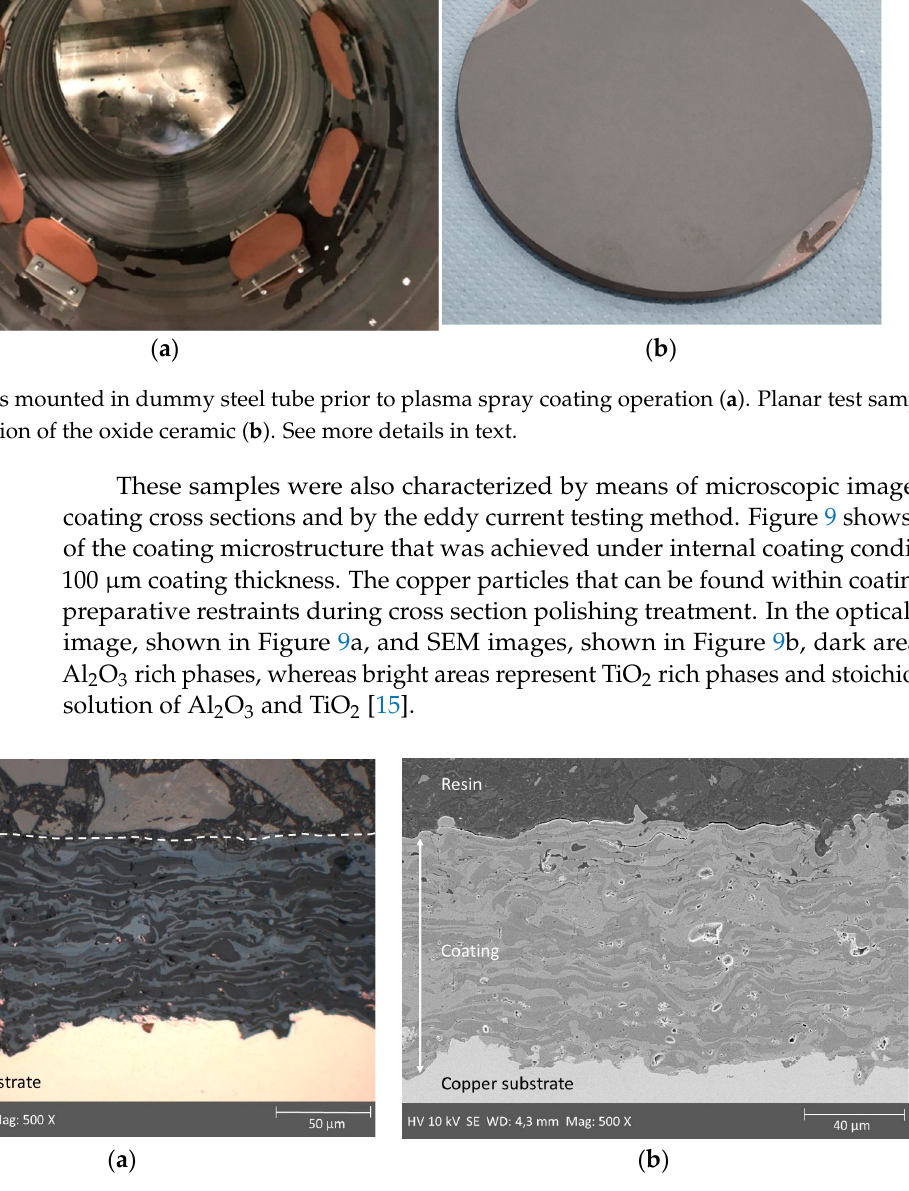
Figure 9. Microscopic images of coating cross-sections in optical microscope ( a ) and SEM ( b ). Some copper particles can be found within the ceramic coating near the interface. This happens due to the polishing process during cross-section preparation.